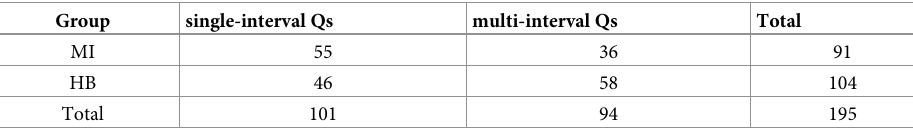
Table 3. Number of single- and multi-interval Qs, per